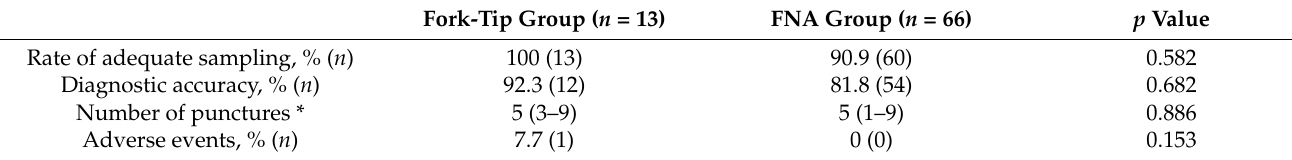
Table 3. Results of EUS-FNA/B.